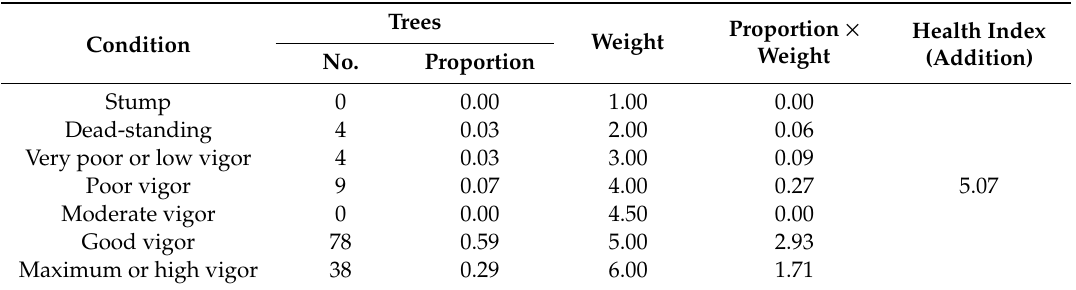
Table 1. Example of health index calculation in a selected conglomerate (conglomerate ID 39373, National Forest and Soils Inventory (NFSI)